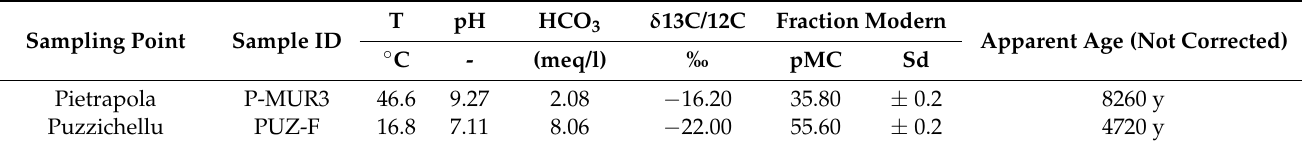
Table 4. Radiocarbon data and related physico-chemical parameters on non-gaseous thermal (P-MUR3) and cold (PUZ-F) springs. The “apparent age” refers to Stentröm, 2011 calculations [75]. The mention “not corrected” refer to radiocarbon age that is not adjusted for any hydro-geochemical effects on meteoric water 14 CO 2 or neither adapted for hydrologic flow